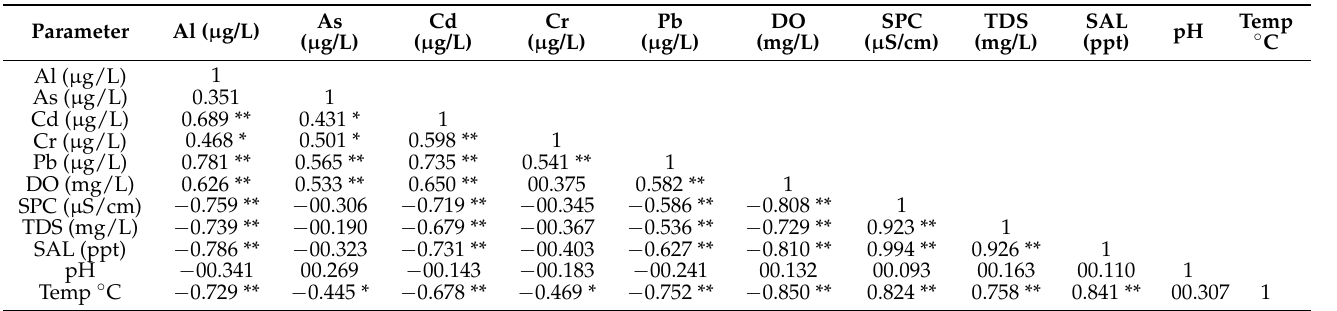
Table 7. Pearson correlation among metals and physicochemical